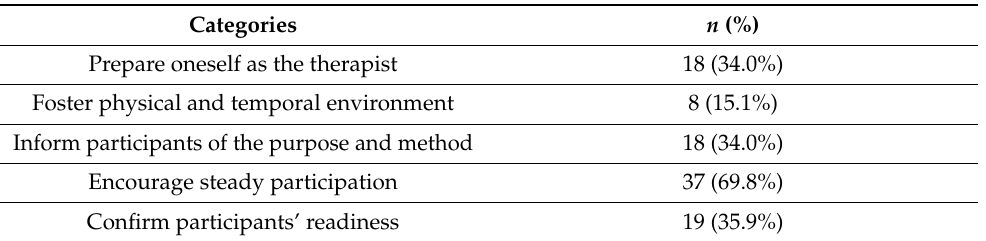
Table 3. Factors to be considered by therapists regarding a gratitude journaling intervention ( n = 53). Categories n (%) 18